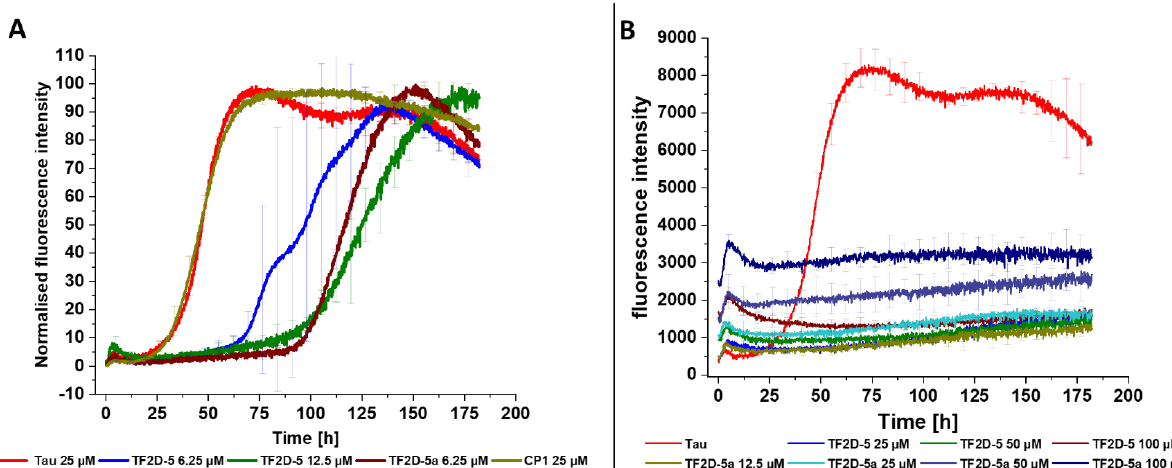
Figure 6. ThT experiment with sub-stoichiometric D-peptide concentrations. ( A ) Normalized sum- mary of all peptide concentrations that did not completely inhibit tau aggregation during the exper- iment. Concentration of full-length tau was 25 µ M. Addition of 6.25 µ M of TF2D-5 resulted in an average lag time increase of about 30 h or 100%, while 12.5 µ M shifted the average lag time by about 60 h or 200%. Addition of 6.25 µ M of TF2D-5a increased the average lag time by about 60 h or 200%. CP1 in a concentration of 25 µ M had no effect on the lag time. ( B ) Non-normalized summary of all peptide concentrations that fully inhibited tau aggregation for the duration of the